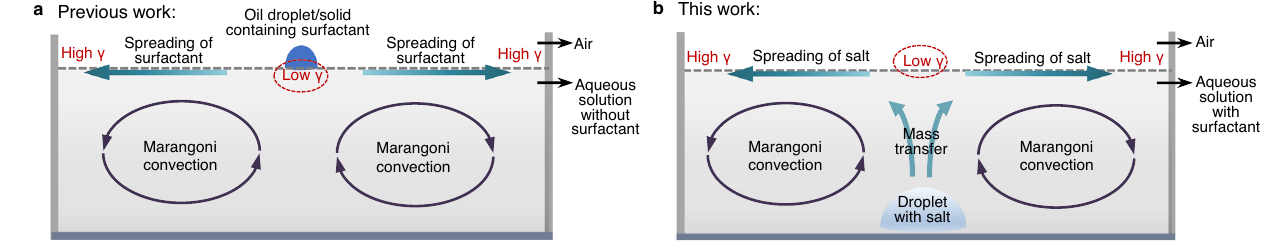
Fig. 1 | Mass transfer based onsolutal Marangoni effect. a Generation of SFT ( γ ) gradients by the addition of an oil droplet or a solid containing surfactant to an surfaceoftheaqueoussolution,andtheresultingMarangoni-drivenspreadingand